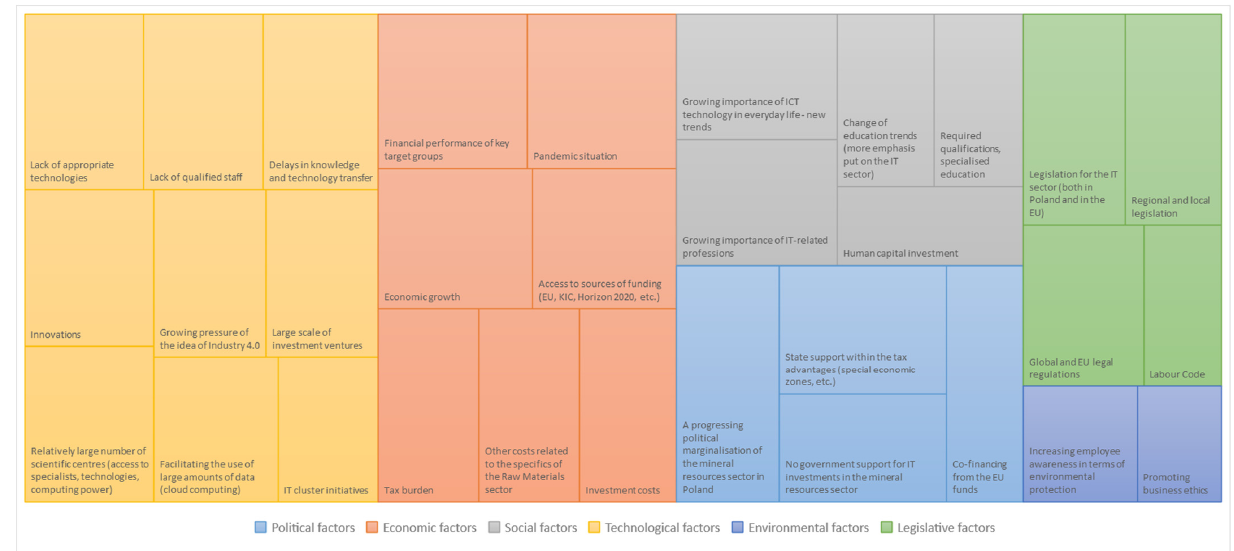
Figure 6. Six groups of PESTEL analysis factors. Authors’ own study.